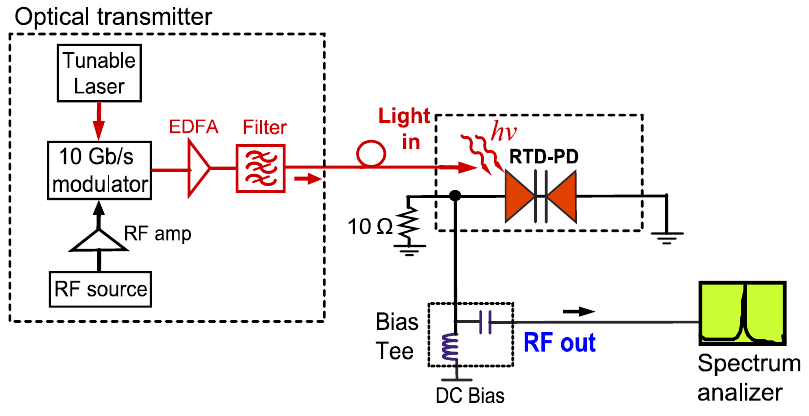
Figure 5. RTD-PD oscillator circuit schematic, and setup of the optical injection locking